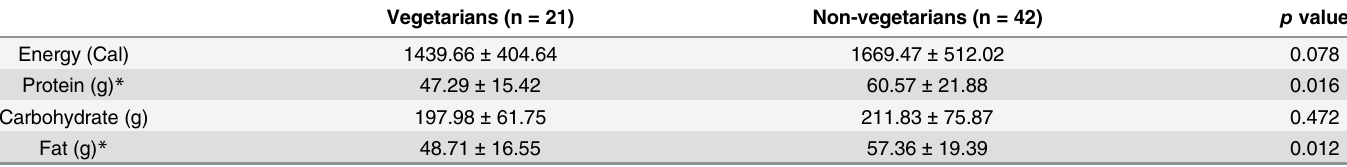
Table 3. Comparison of dietary composition between vegetarians and non-vegetarians.